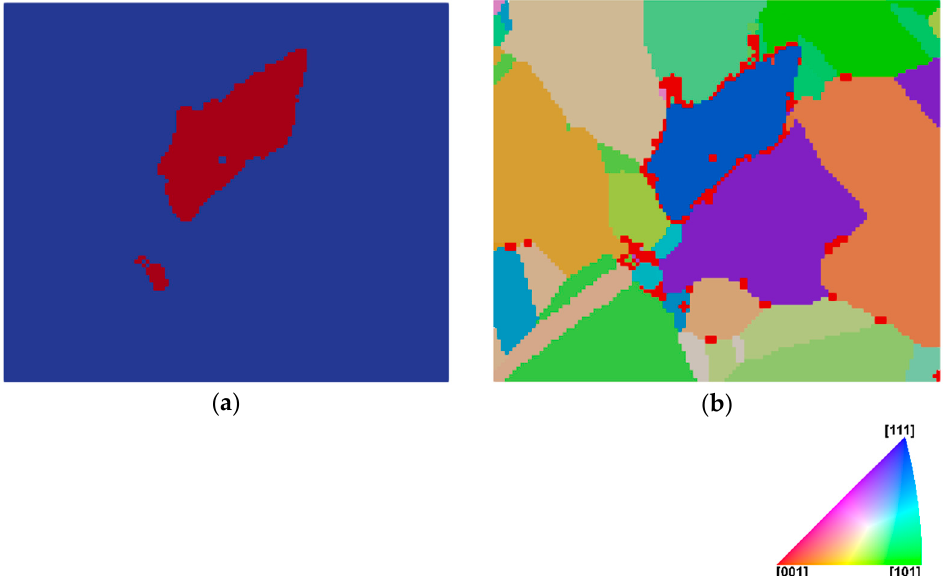
Figure 5. Generated geometry file from the actual EBSD map of TRIP steel MMC: ( a ) phase map, where blue represented an austenitic steel matrix, and red represents zirconia; ( b ) Inverse pole figure (IPF) map of the geometry, where a different color represents each grain as per the given IPF legend.